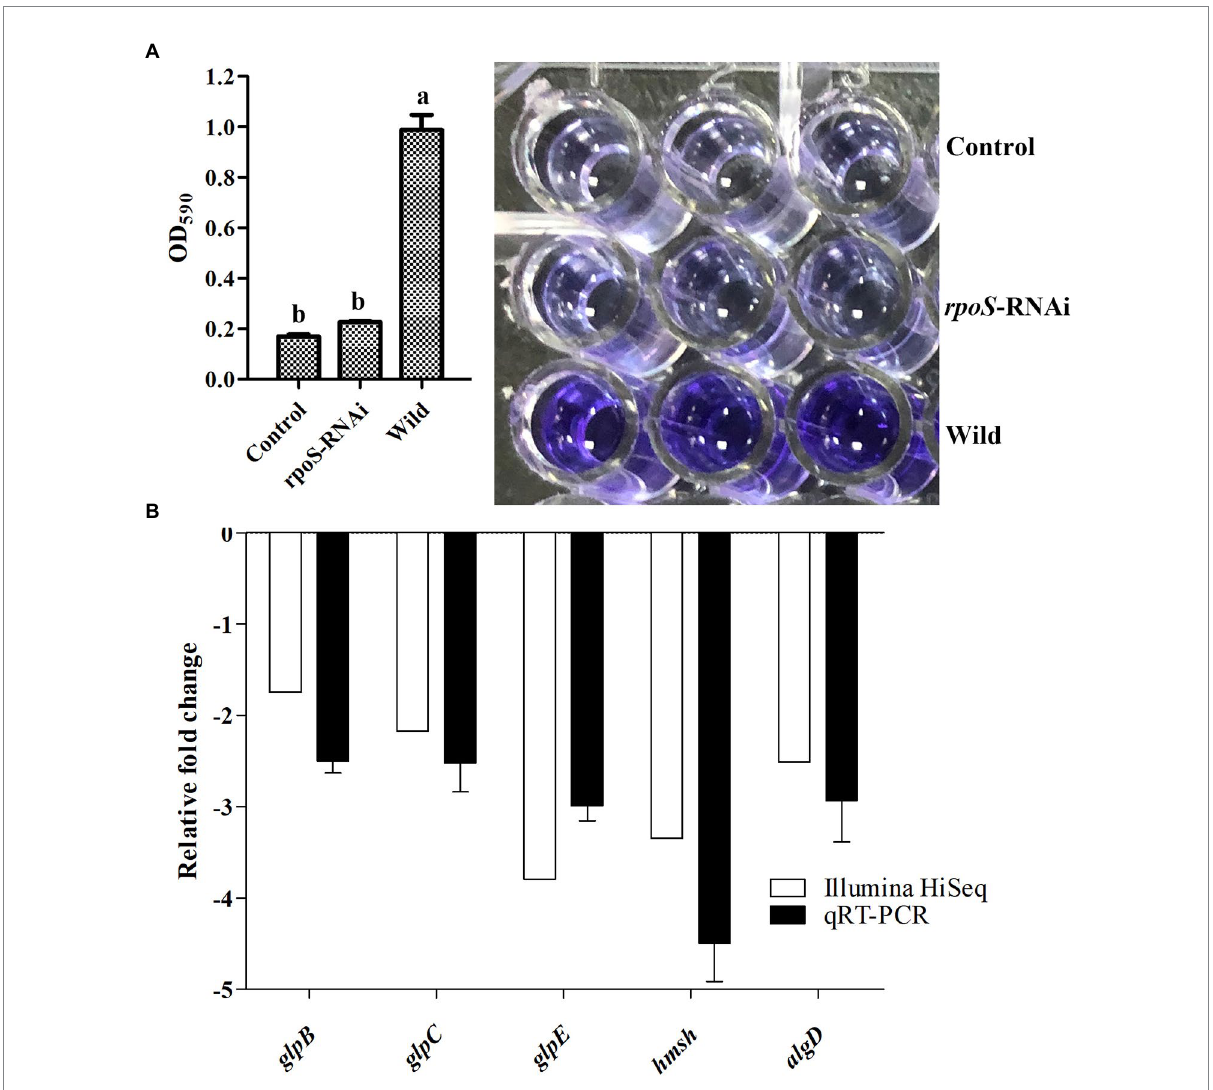
FIGURE 4 Effect of rpoS on biofilm formation in E. cloacae . (A) Biofilm formation ability of wild-type and rpoS -RNAi strains. (B) Expressions of biofilm formation related genes in rpoS -RNAi strain; The values marked with different letters (a, b) are significantly different ( p <